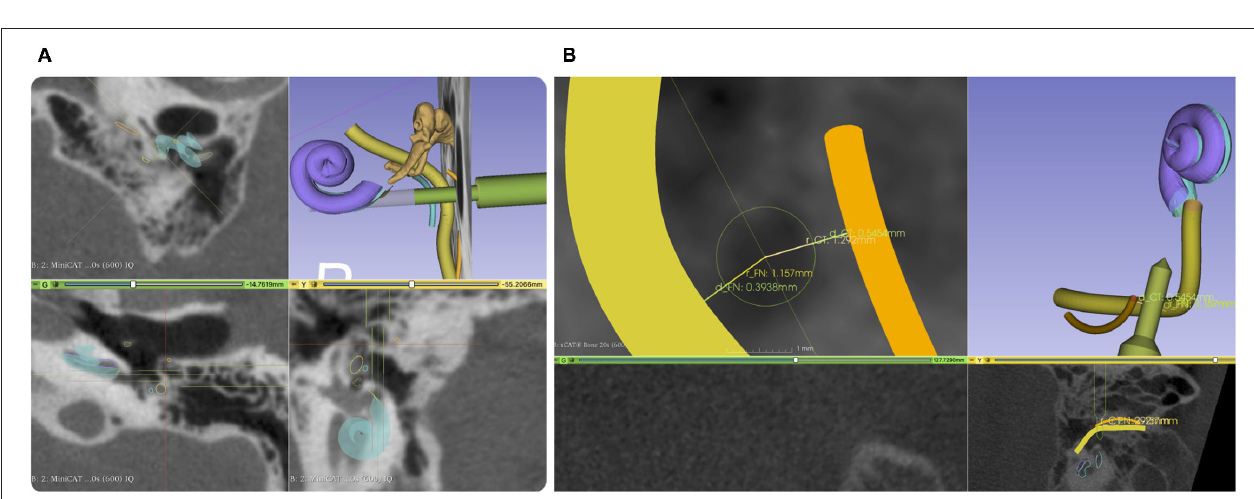
FIGURE 5 | (A) Screenshot from our planning software. An access path (green) is planned with a diameter of 1.5 mm and 3 mm through the facial recess. The facial nerve (FN) is shown in yellow and the chorda tympani (CT) in orange. (B) A close-up of the projection view in the direction of the planned drill path. Here, we do not measure the width of the facial recess but the effective width referred to the central axis of the planned access path. To better compare drill diameter to the facial recess width, we report two distances, one for each